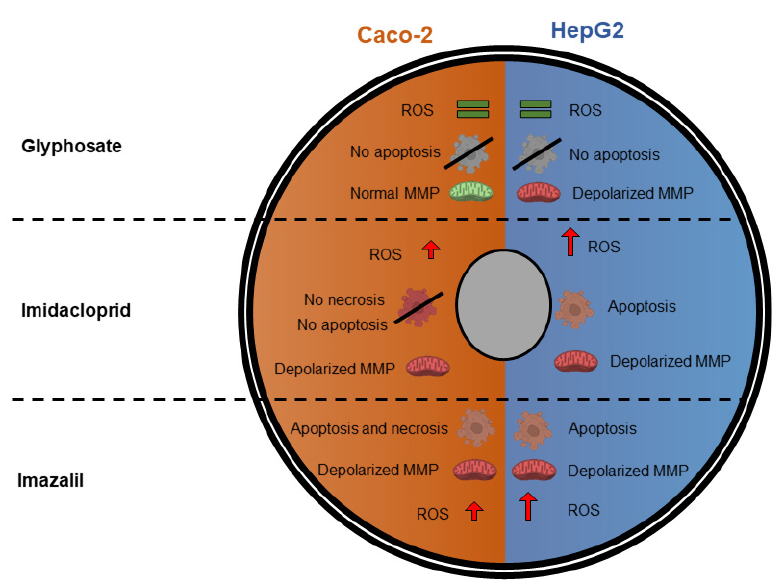
Figure 9. Summary of GLY-, IMD-, and IMZ-induced changes on oxidative stress and apoptosis/ne- crosis in Caco-2 and HepG2 cells.